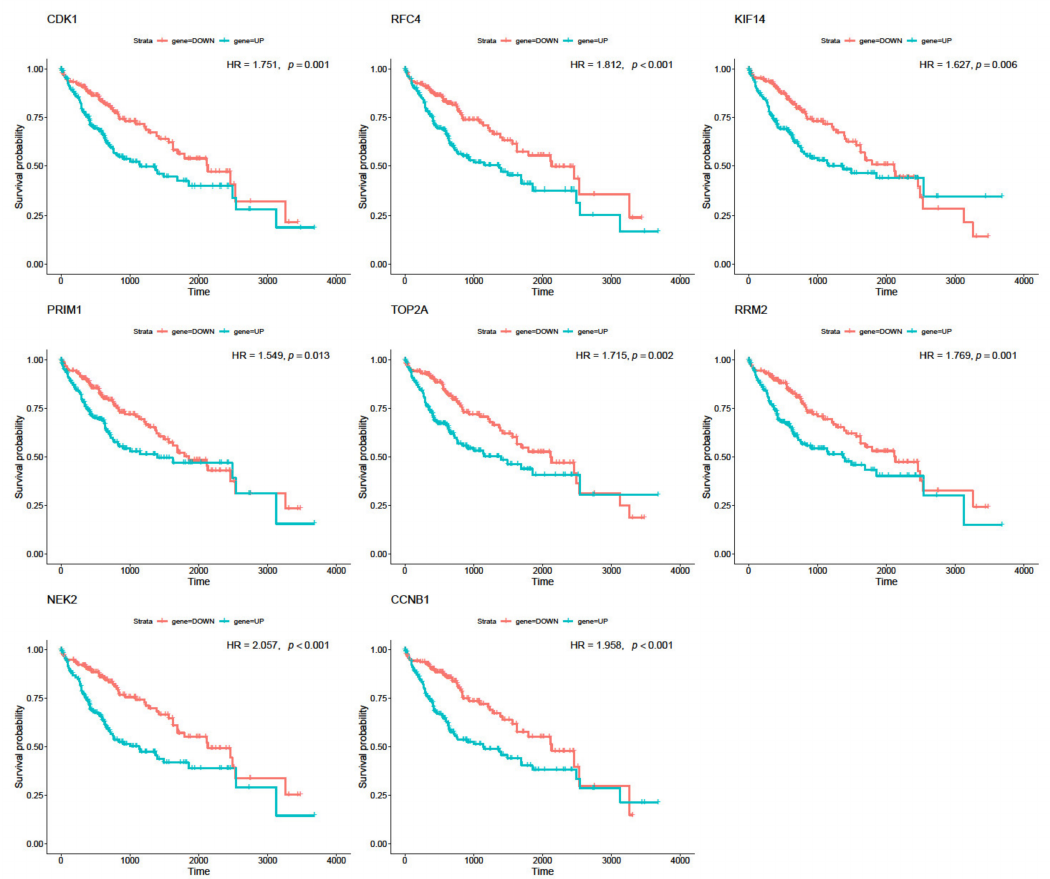
Figure 4. Survival analysis of five potential hub genes obtained from gene co-expression and PPI networks and three other genes of the top ten genes with the highest intramodular connectivity ( RFC4 , KIF14 , and PRIM1 ) in HCC. Overall survival of the hub genes in HCC is based on Kaplan–Meier plotter. The horizontal axis represents the time to event (in days). The patients were allocated into the high-risk and low-risk groups and assigned a color. The red line designates the samples with low risk, and the green line represents the samples with high risk. p < 0.05 indicates a statistically significant difference in mortality between groups. HR: hazard ratio of the two